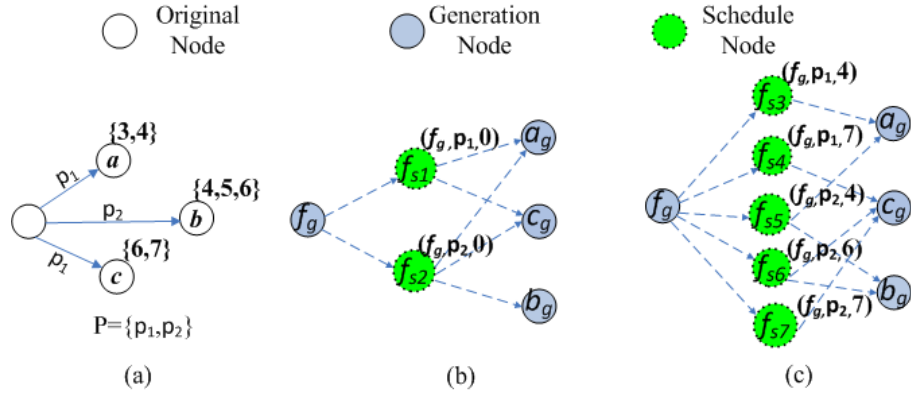
Figure 1. An example of constructing the auxiliary graph. ( a ) The original graph; ( b )The intermediate auxiliary graph; ( c ) The final auxiliary